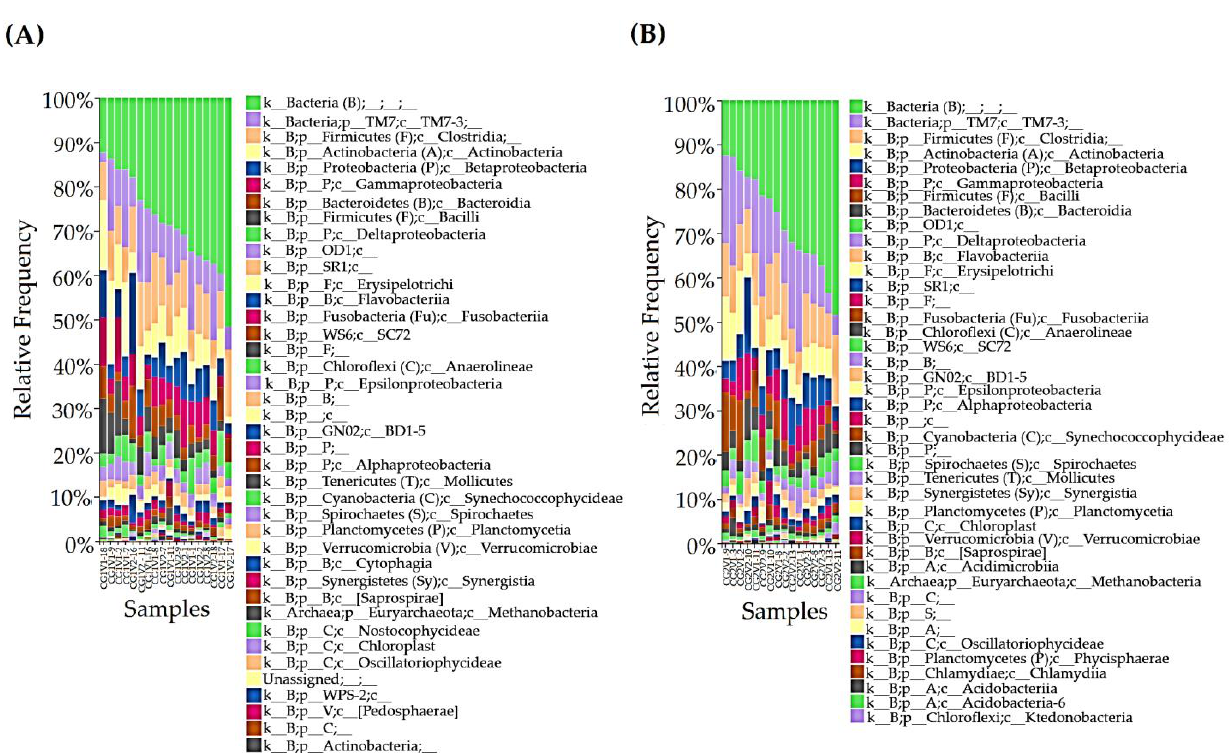
Figure 1. Taxonomical distribution of oral microbiome of experimental cats. ( A ) The comparison of PrTS and PoTS of G1 samples. ( B ) The comparison of PrTS and PoTS of G2. The relative frequency of the sample was compared. PrTS: pretreatment samples; PoTS: post-treatment samples.